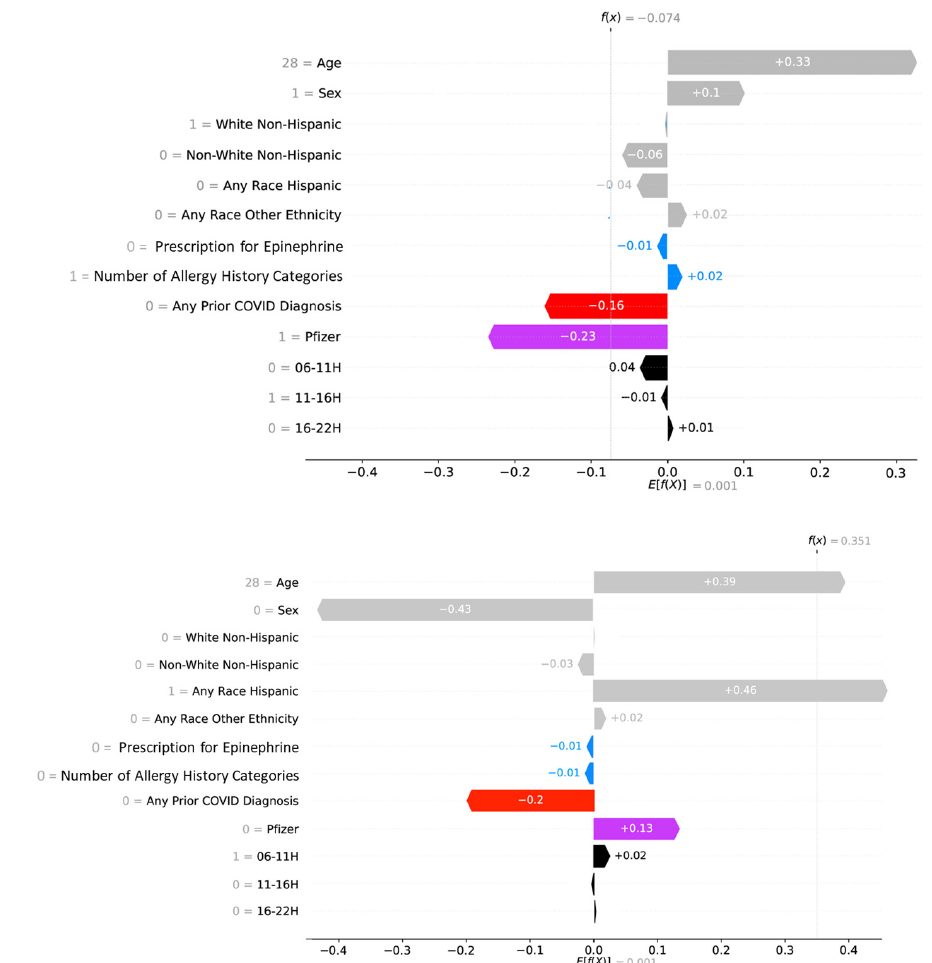
Figure 4. SHAP Waterfall plots exampling local/individual predictions for 4 individuals showing the contribution of each variable to the prediction. The gray text in front of each variable name is the value of the particular variable. The baseline value (E[f(X)]) is displayed below the x -axis, indicating the expected value of the model. The model output for each individual (f(x)) is shown on top of each panel; it is the sum of SHAP values calculated for all variables. Positive SHAP values push the model to predict having side effects, while negative SHAP values push the model to predict no side effects. Allergic side effects: ( A ): a 28 year old white non-Hispanic male who received Moderna between 16 and 21:59. ( B ): a 28 year old male with any race Other Ethnicity who received Moderna between 16 and 21:59; Non-allergic side effects: ( C ): a 28 year old white non-Hispanic female who received Pfizer between 11 and 15:59, and ( D ): a 28 year old male with any race Hispanic who received Moderna between 06 and 10:59. Absolute SHAP values < 0.01 were not presented on the figures. Colors: grey- demographics, blue- allergy history category/prescription for epinephrine, red- any prior COVID diagnosis or positive test, purple- vaccine manufacturer, black- time-of-day of vaccination.